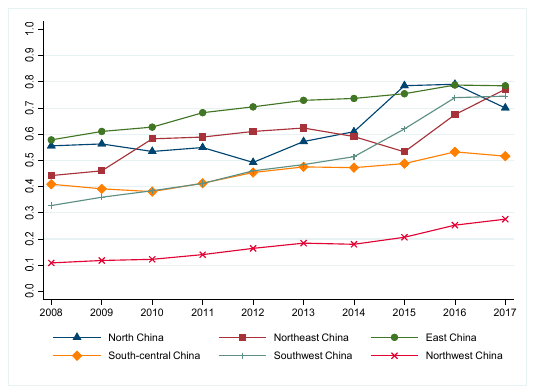
Figure 3. Regional real eco-efficiency of China’s tourism industry (2008–2017). The average eco-efficiency in Stage Ⅲ and Stage Ⅰ of each province is represented in Figure 4 to investigate the spatial distribution and regional gaps of China’s tourism